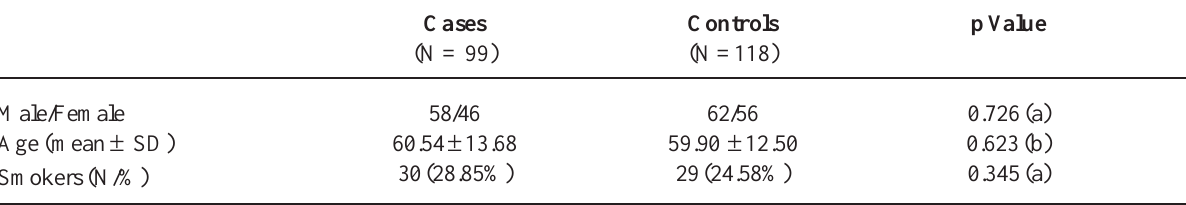
Table 1 – Characteristics of cases and controls.